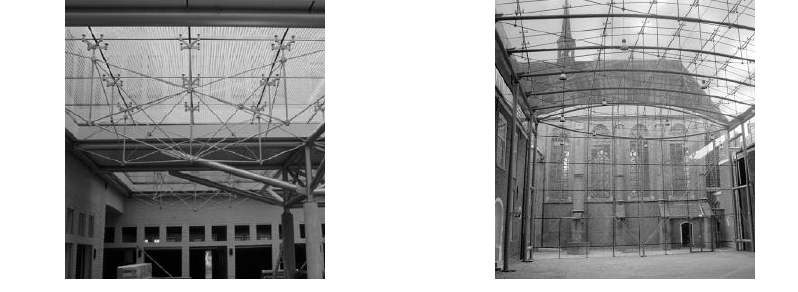
Figure 11: Court of Justice in Maastricht. Figure 12: Prinsenhof Glass Museum hall in